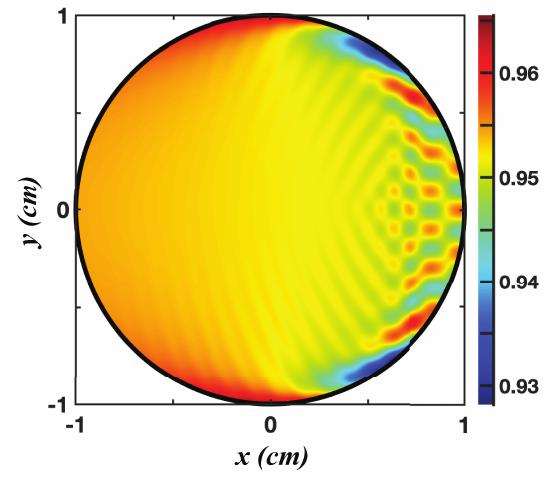
Figure 5. A magnified view of the normalized, time-averaged Poynting flux inside the